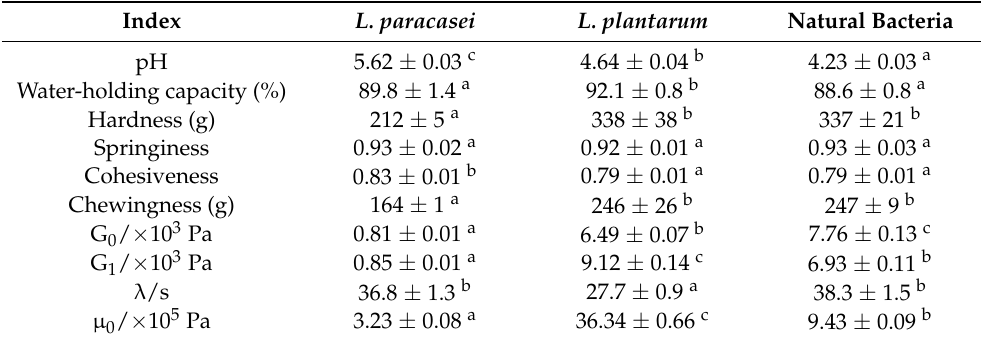
36.34 ± 0.66 c 9.43 ± 0.09